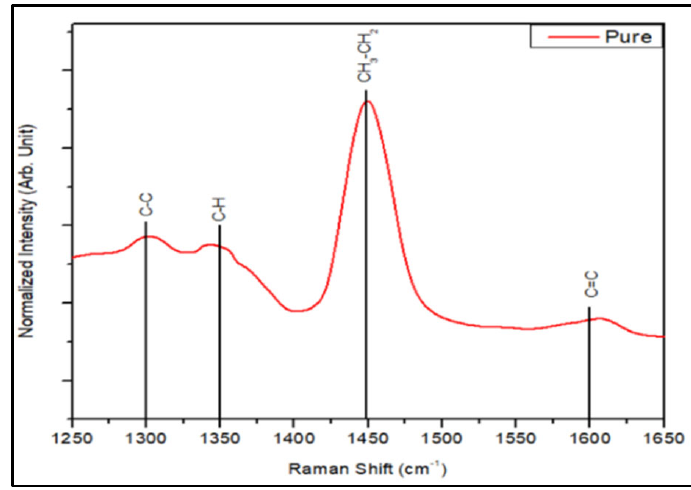
Figure 13. Raman spectrum of pure MO in the first-order region. The characteristic of disorder in structure can be seen by using the peak intensity ratio, as shown in Table 7. Pure MO has the highest intensity ratio of 0.4855, which indicates the presence of high disorder in the samples, while the lowest intensity ratio is from the 0.005 g/L sample, with the value of 0.3889. This shows that the higher the value of the intensity ratio, the lower the breakdown voltage. The D-peak with the highest value of intensity verifies the presence of oxygen functional groups in the samples. Furthermore, a large reflection of the structural distribution indicates that the structure crystallinity is reduced or damaged. By reflecting the structural distribution, the 0.005 g/L sample has the lowest intensity, which suggests the structure of the molecule is stable and is believed to have good electrical properties. Table 7. Intensity ratio of D-peak to G-peak of different types of